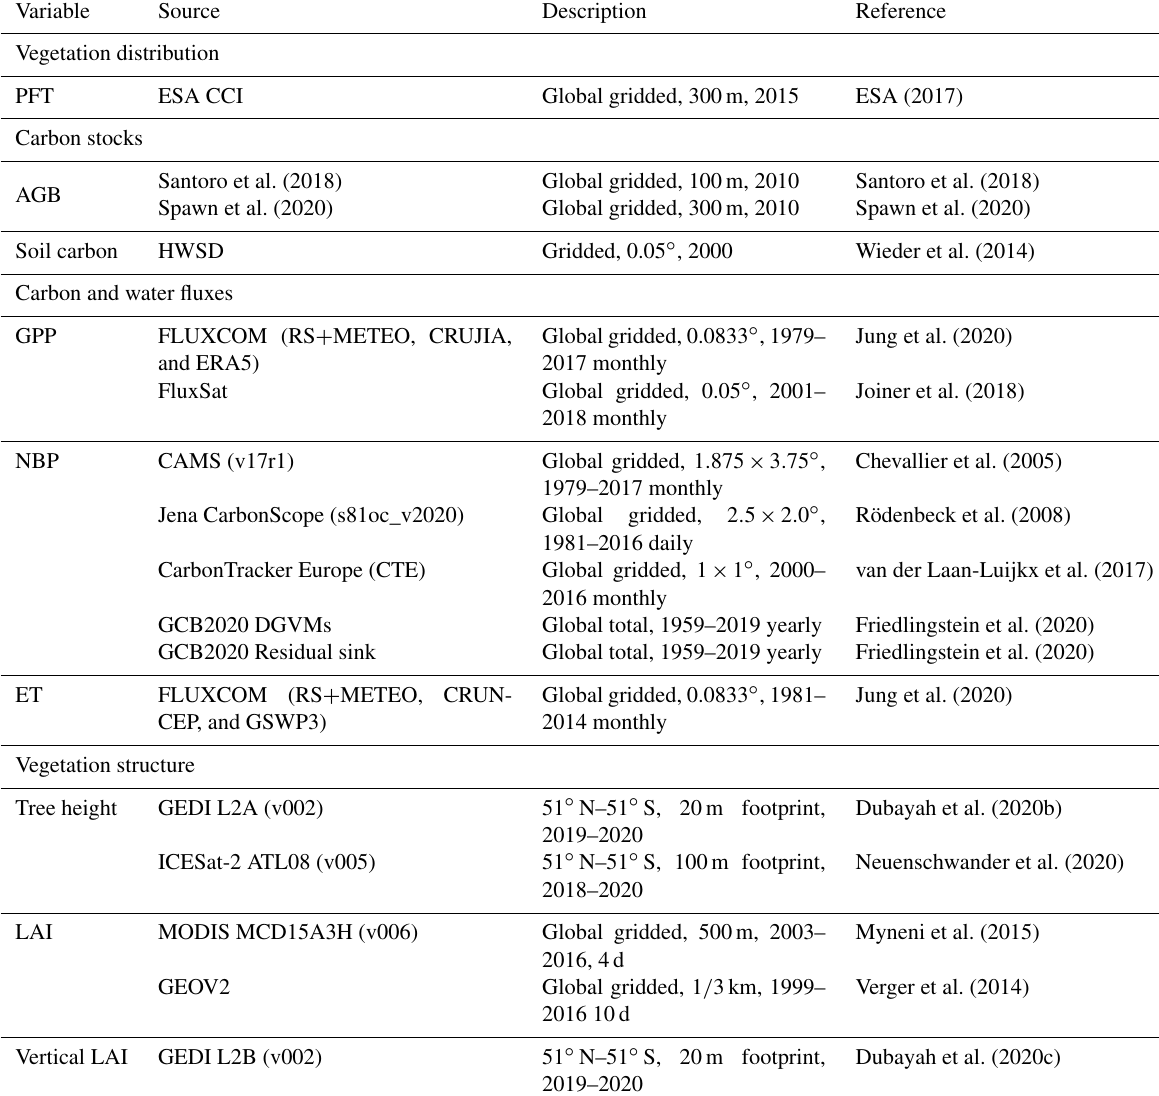
Table 1. Summary of benchmarking datasets used for ED model